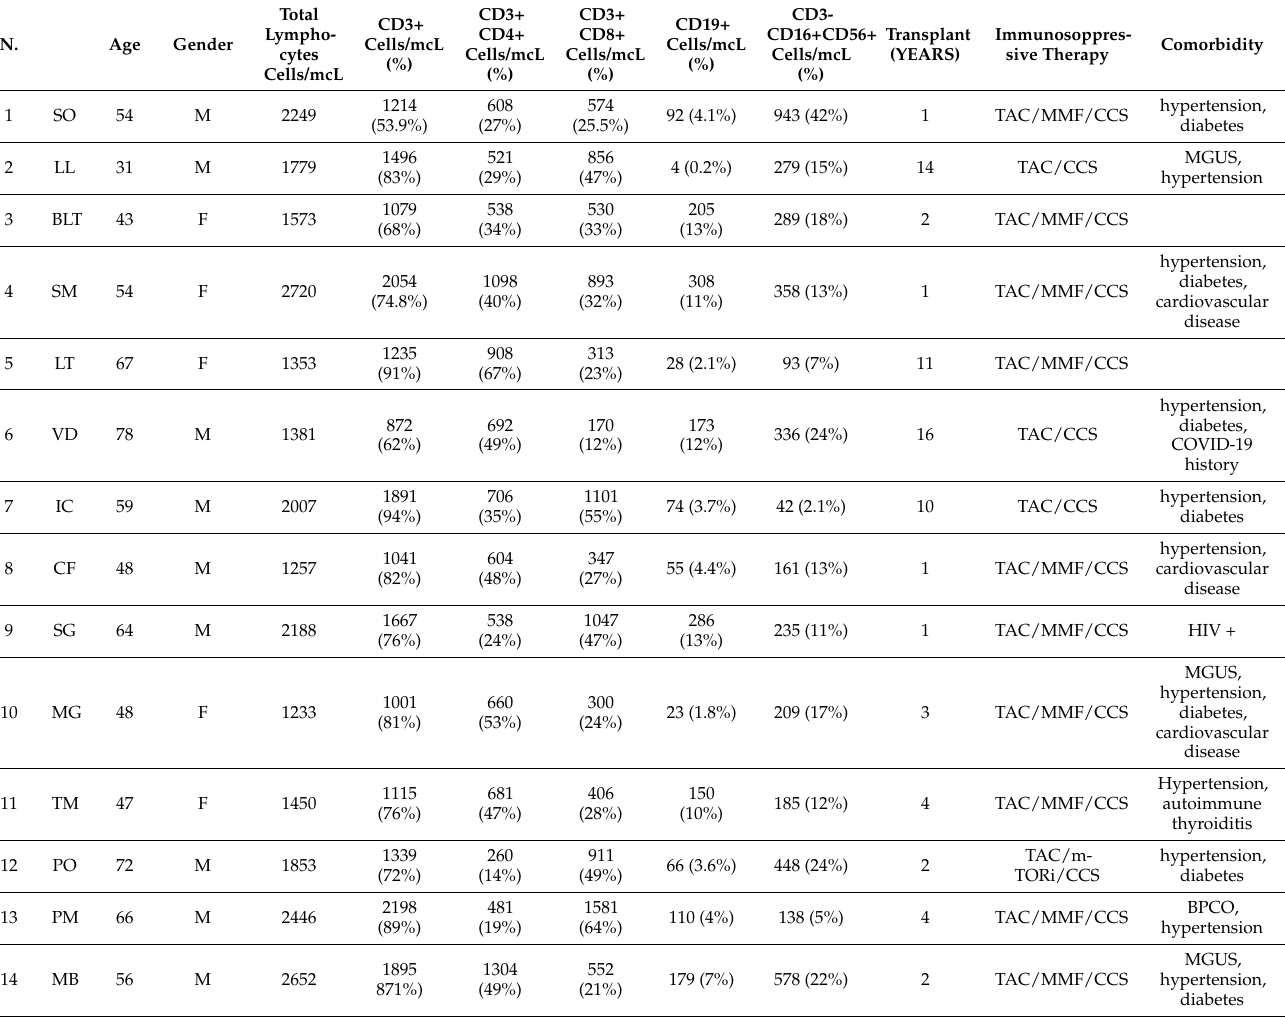
Table 2. Demographic, clinical and laboratory characteristics of 14 kidney transplant